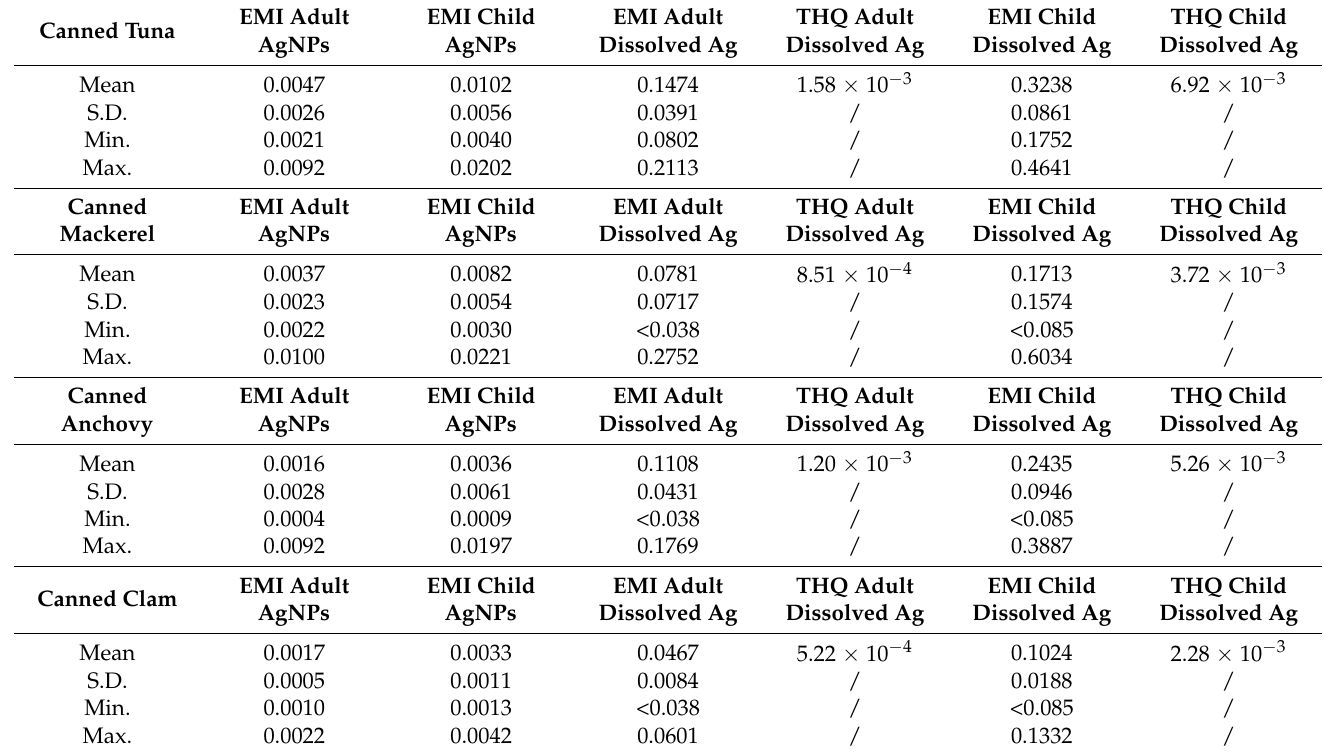
Table 4. Descriptive statistics of Estimated Meal Intake (EMI µ g/Kg b.w.) calculated for adult (70 years) and child (6 years) concerning the AgNPs and dissolved Ag and, THQ calculation concerning dissolved Ag for adult (70 years) and child (6